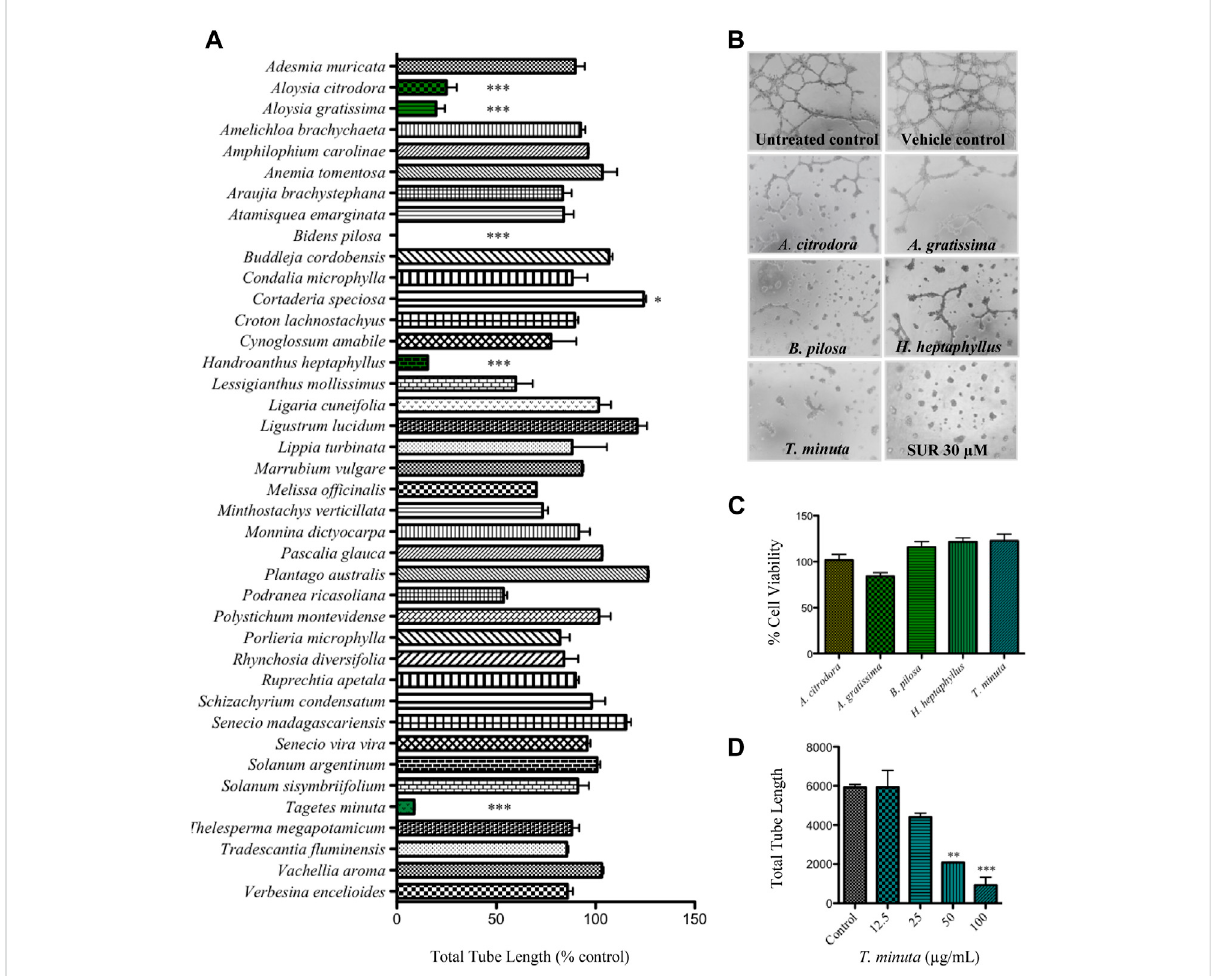
FIGURE 1 Theantiangiogenicactivityoftheplantethanolextractswasassessed bymeansofthetubeformation assay. (A) After18 hincubation, theBAEC endothelial tubular network was analyzed, and the total tube length was quanti fi ed using the ImageJ software. Data are shown as percentage of the respective control (1% ethanol, vehicle) and represented as the mean ± SEM. Statistical analysis was performed by ANOVA followed by Dunnett ’ s post-hoc test (*** p < 0.001, * p < 0.05). (B) Representative images of BAEC cell capillary-like structures when treated with 100 μ g/ml of the antiangiogenic plant extracts, untreated control, negative control (vehicle) and the suramin sodium positive control (SUR, 30 μ M). (C) Cell viability after24 htreatmentwiththeantiangiogenicextractswasassessedintermsoftheMTTassay.Thepercentagesofcellviabilityreferredtothenegative control (1% ethanol, vehicle) are expressed as the mean ± SEM. (D) Dose-response curve of Tagetes minuta extract. The bars show the total tube length expressed as the mean ± SEM. Statistical analysis was performed by ANOVA followed by Dunnett ’ s post-hoc test (*** p < 0.001, ** p <